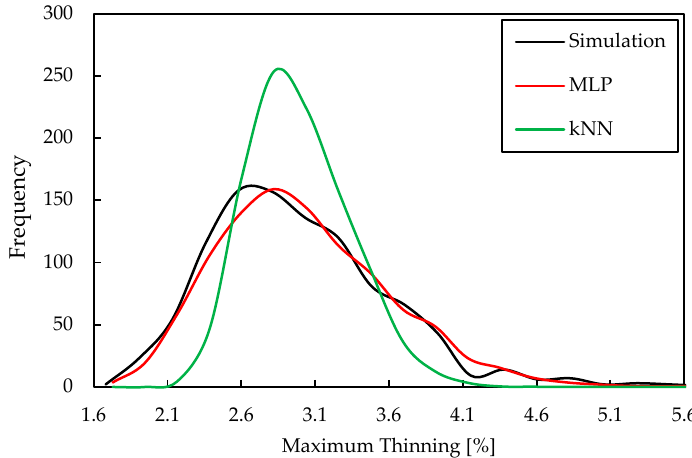
Figure 3. Frequency distributions obtained for the numerical simulations and predictions by the MLP and kNN algorithms, considering the maximum thinning in the U-Channel case with the DC06 material.